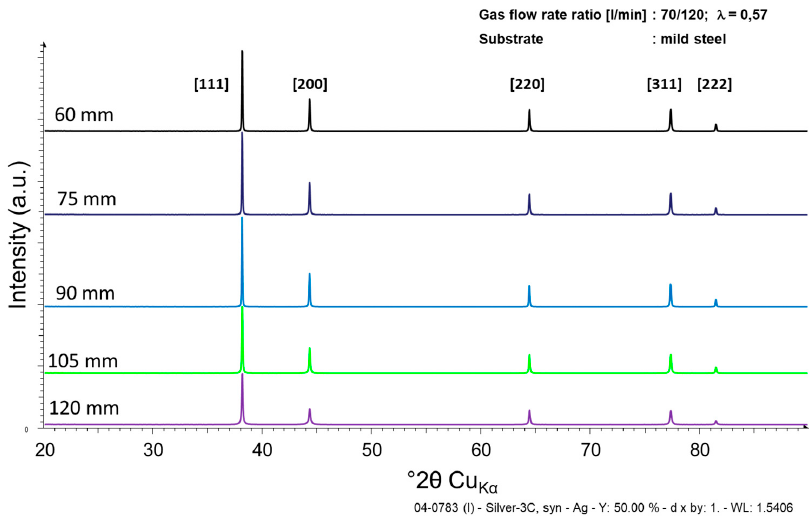
Figure 18. XRD spectrum of HVSFS sprayed Ag coatings as a function of spray distance (assigned as 60, 75, 90, 105, and 120 mm in the graph). Data correspond to samples in Figure 15, second row (60, 90, 120 mm).